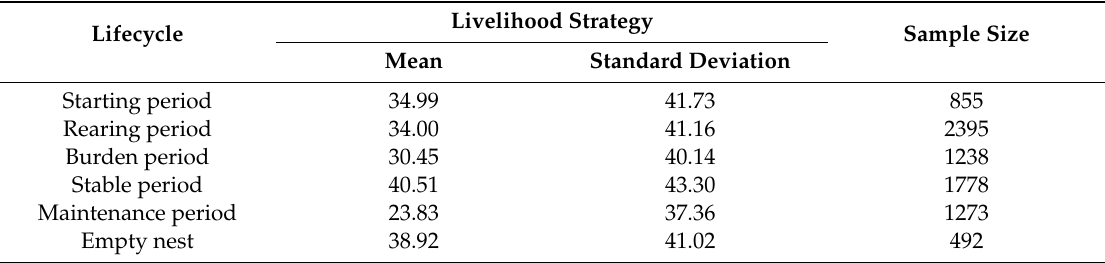
Table 4. Strategies of rural households in di ff erent family life cycles and their di ff erences. Lifecycle